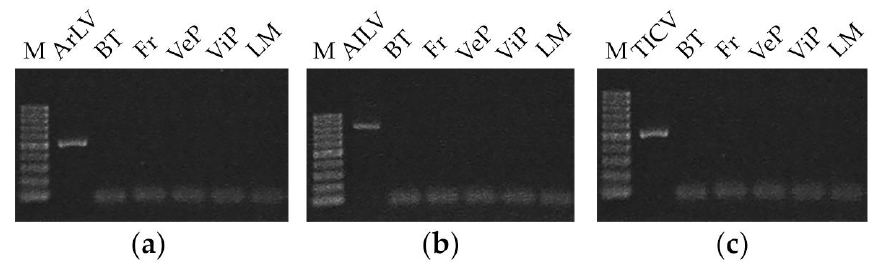
Figure 3. RT-PCR performed with primer pairs specific for ( a ) ArLV; ( b ) AILV and ( c ) TICV on nucleic